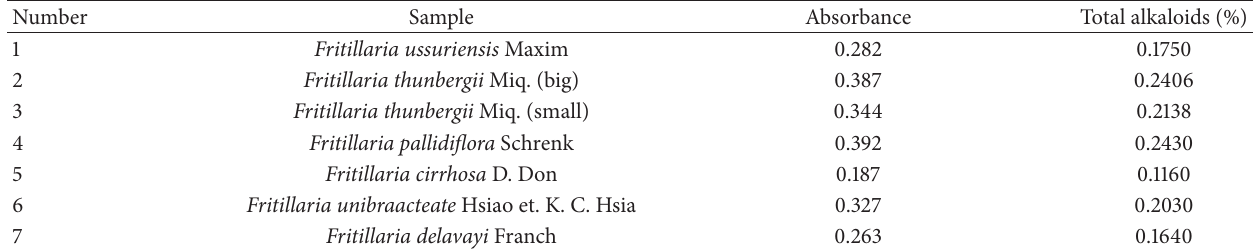
Table 2: Content of total alkaloids from seven Fritillaria samples by UV